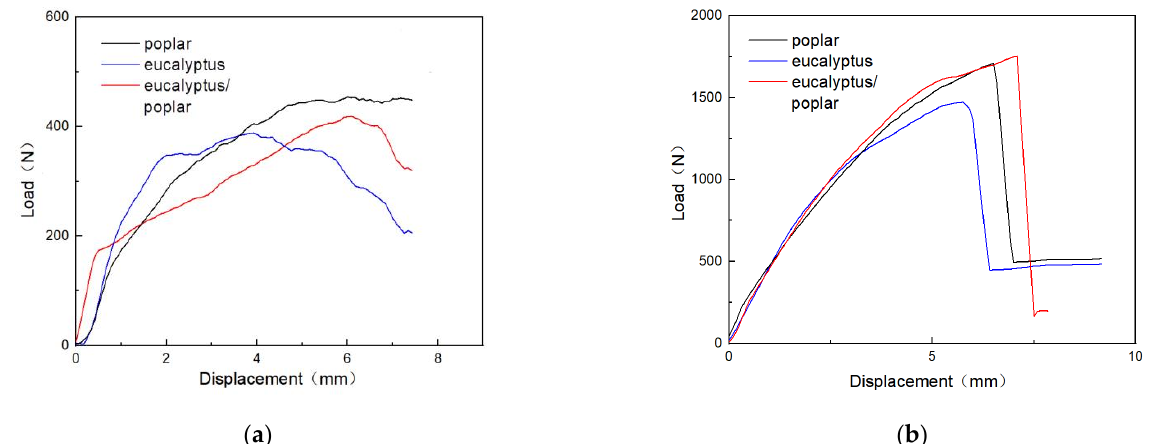
Figure 8. Three kinds of plywood load–displacement curves: ( a ) one staple; and ( b ) four staples. Figure 8. Load-displacement curves for the lateral holding strength of three kinds of plywood: ( a ) one staple; and ( b ) four